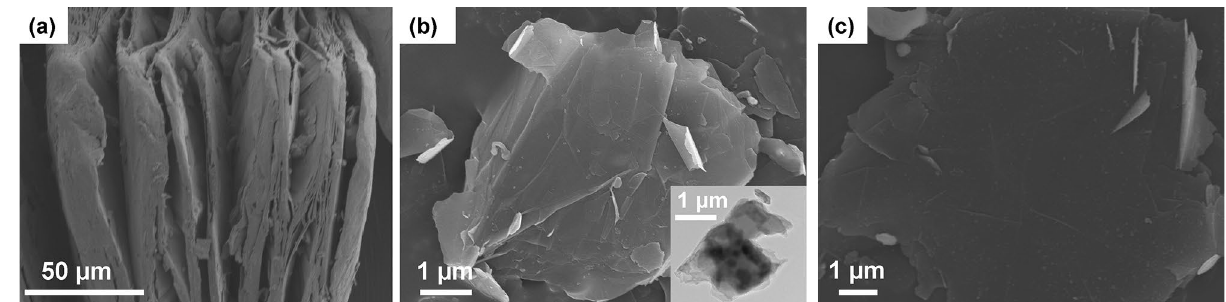
Figure 4. Characterization of GnF morphologies. ( a ) Intercalated graphite (before exfoliation). ( b – c ) GnFs with a gamma-ray radiation dose of ( b ) 0.0 kGy and ( c ) 5.0 kGy. Inset in ( b ) shows the TEM